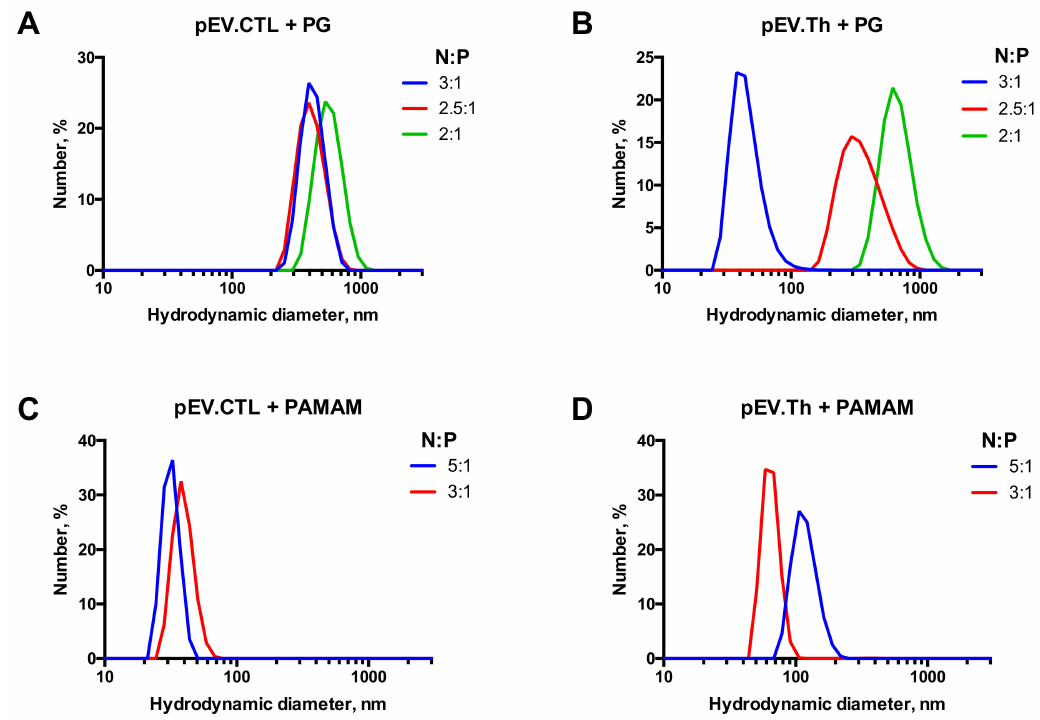
Figure 5. Size distribution profiles of nanoconstructions formed by DNA vaccines pEV.CTL and pEV.Th upon complexation with PG ( A , B ) and PAMAM G4 ( C , D ).